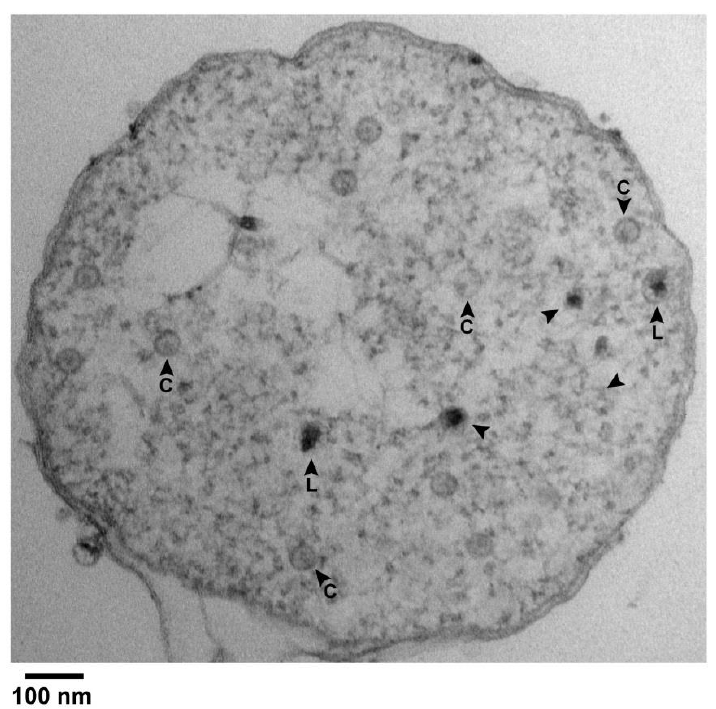
Figure 4. Black particles in a cell with partially leaked cytoplasm. Uranyl acetate/lead staining was used. An image is shown of the entire cross section of an infected cell. Arrowhead, black particle; C, capsid; L, large.